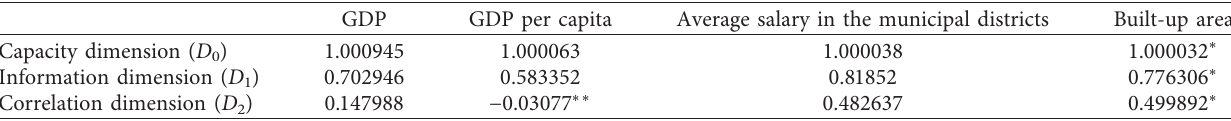
Figure 4: Illustration of the multifractal analysis for four provinces and one city in the lower reaches of the Yangtze River. (a) Illustration of the multifractal analysis of the scale of GDP. (b) Illustration of the multifractal analysis of the GDP per capita. (c) Illustration of the multifractal analysis of the average salary in the municipal districts. Table 3: Results of the multifractal analysis for the four indicators of four provinces and one city in the lower reaches of the YangtzeRiver. GDP GDP per capita Average salary in the municipal districts Built-up